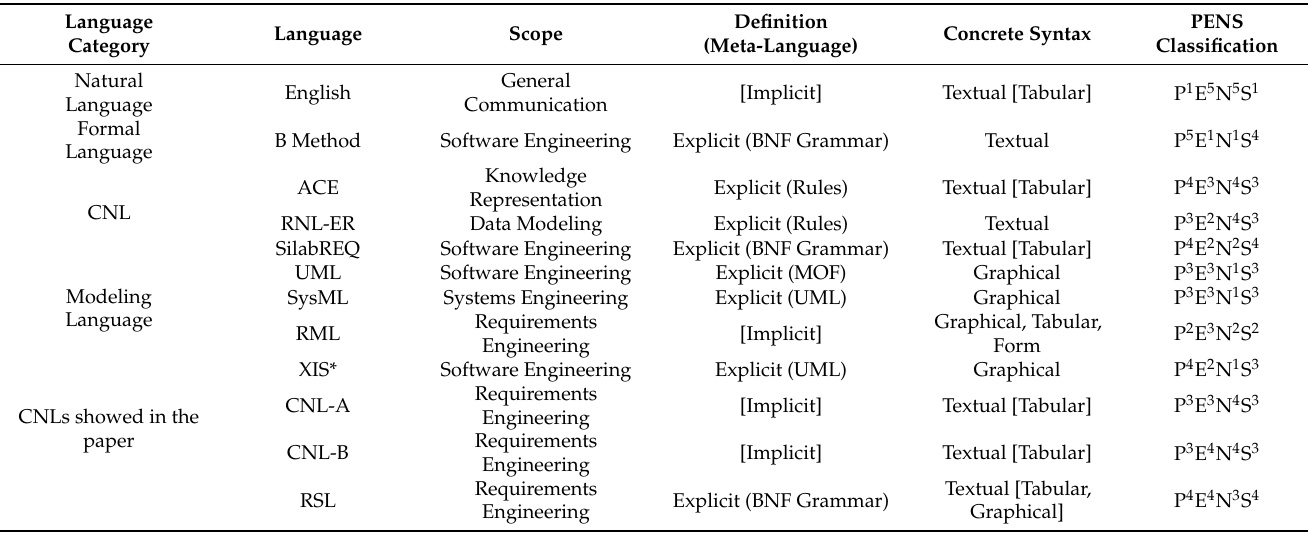
Table 2. Comparison of languages used for data entity specification and data modeling: PENS